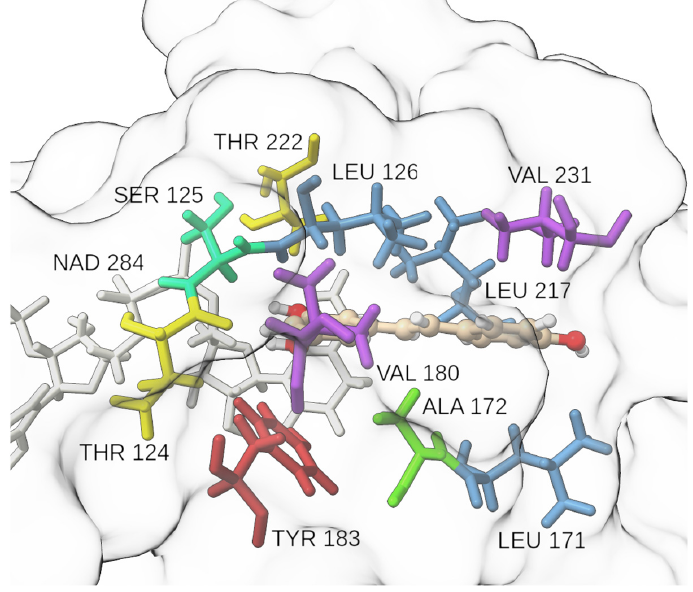
Figure 8. Insight into the catalytic site neighborhood for the RES:11 β -HSD-1 complex. Ala (green), Leu (blue), Thr (yellow), Tyr (red), Val (violet), white (NADPH), ball-and-stick model (RES)